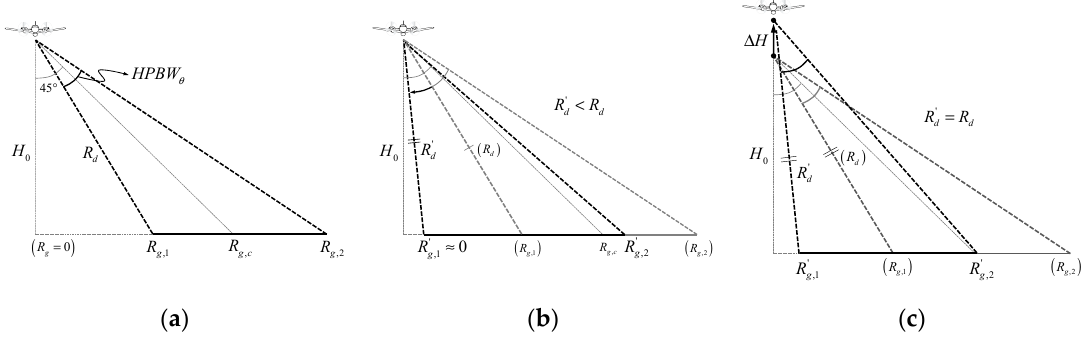
Figure 5. Geometry of the delayed-dechirp process: ( a ) is the automatic setup referred to as a beam center of the fixed incident angle, and ( b , c ) are two options of manual setup to adjust the incident angle.